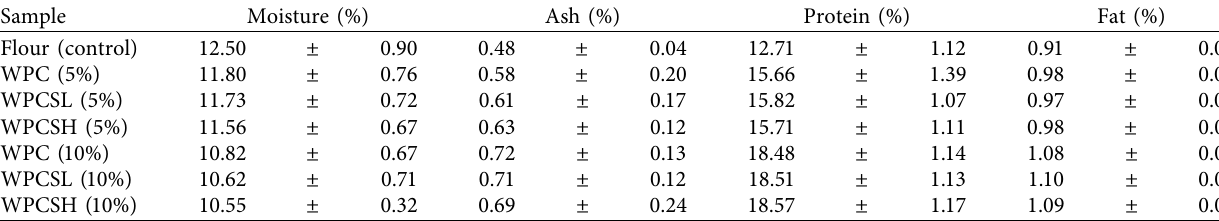
Table 2: Chemical composition values before processing.